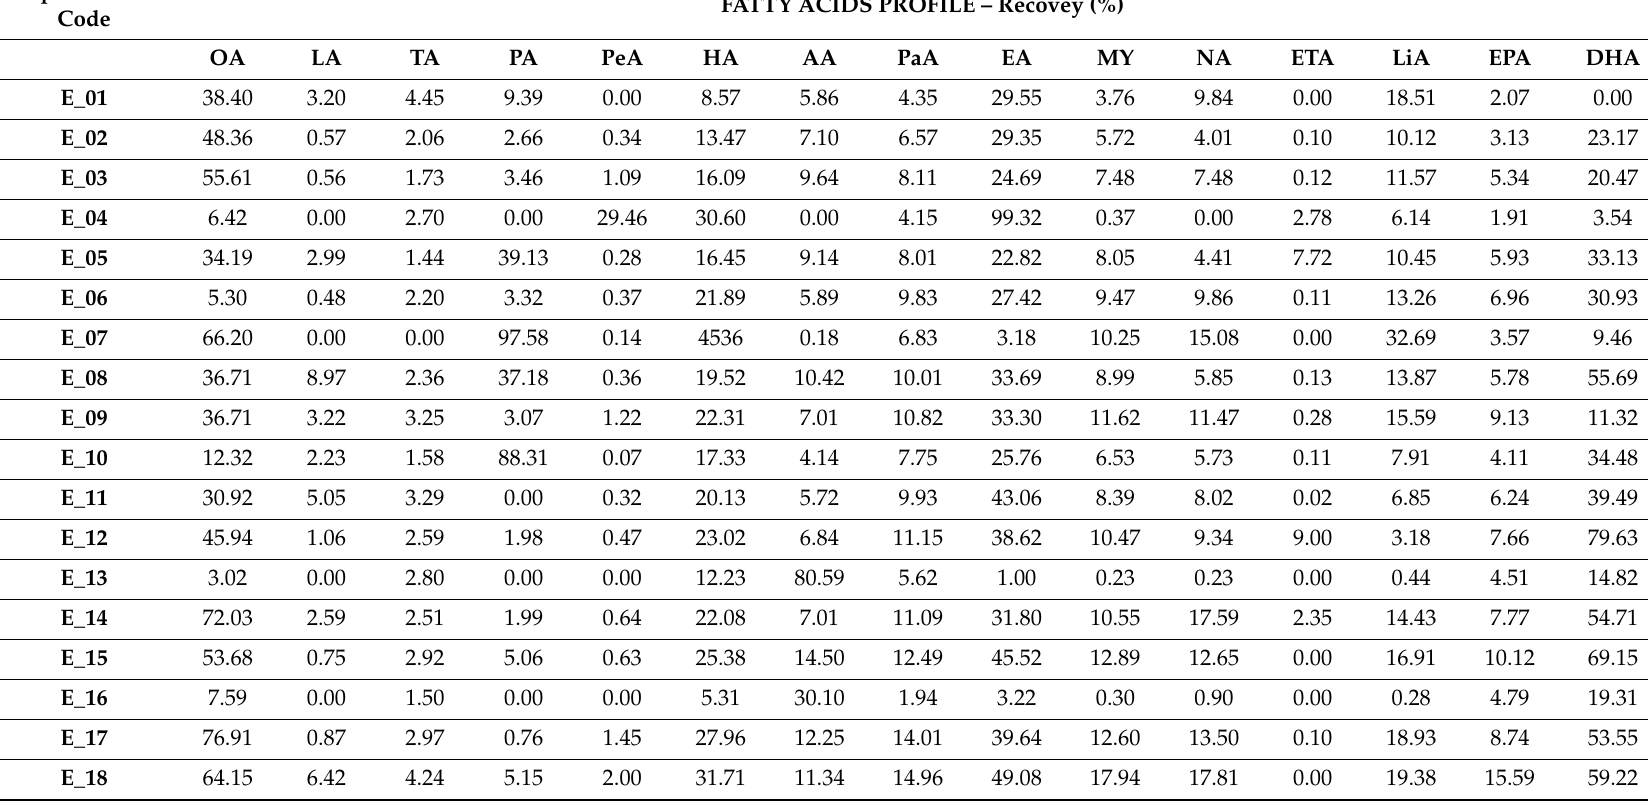
Table 2. Composition of FAs extracted from Nannochloropsis sp. Biomass: Comparison between di ff erent SF-CO 2 extraction conditions.